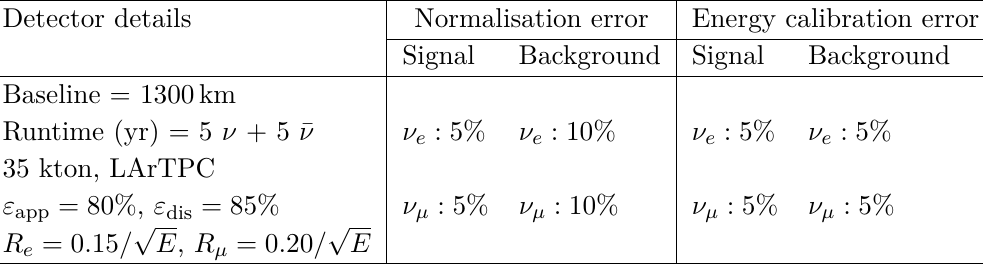
Table 2 . Details of detector configurations, efficiencies, resolutions, and systematic uncertainties for DUNE. Here, ε app and ε dis are signal efficiencies for ν CC is energy resolutions for signal ν CC